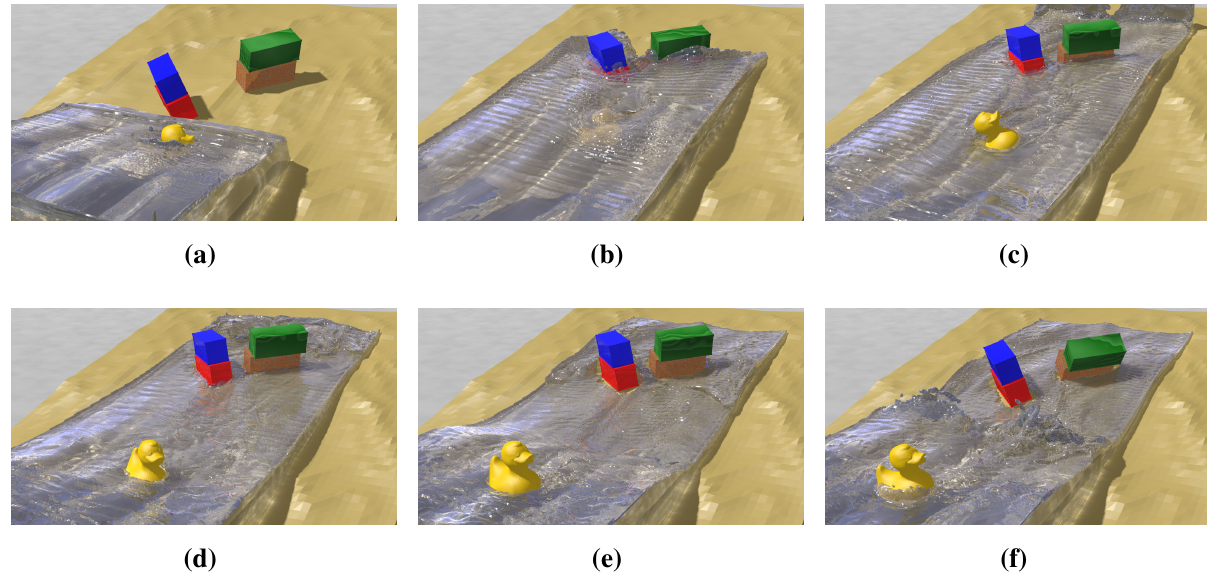
Figure 16. Rendered screenshots of the debris flow simulation. ( a ) t = 0 . 3 s; ( b ) t = 0 . 75 s; ( c ) t = 1 . 2 s; ( d ) t = 1 . 65 s; ( e ) t = 2 . 1 s; ( f ) t = 2 . 5